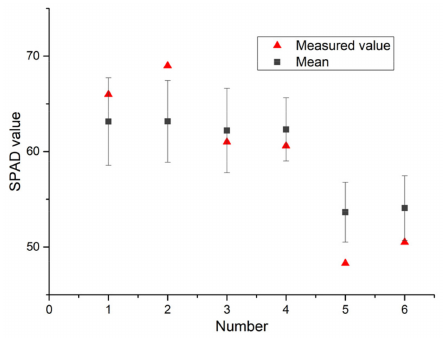
Figure 14. Predicted SPAD value and measured value with the standard deviation as error bars (No.1,2—Figure 11b,f, No.3,4—Figure 12b,f, No.5,6—Figure